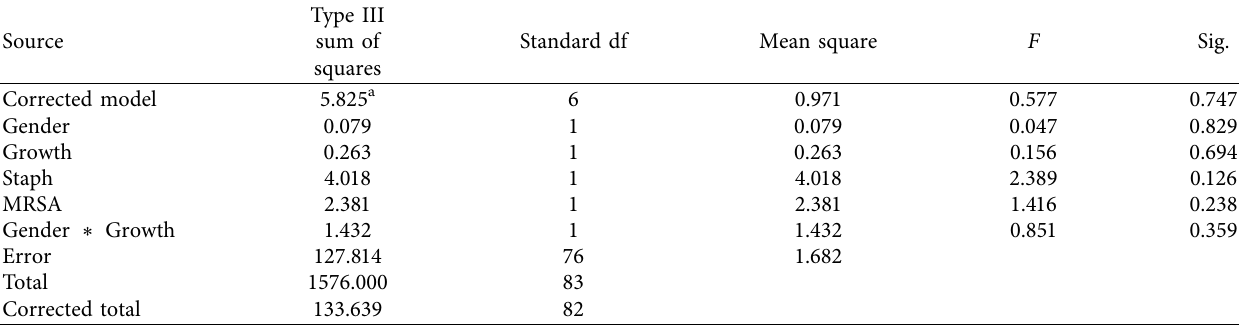
Table 6: Bivariate statistical analysis, dependent variable: age.